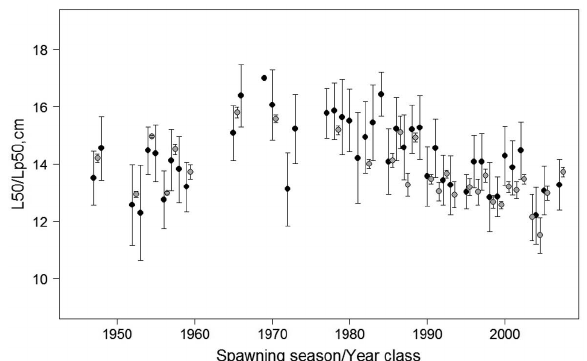
Fig . 4. – Variation in L (black symbols) and Lp (grey symbols) 50 50 of first-time spawners during the period 1948-2007. Bars represent ±2 standard errors of estimates. Fig . 5. – Variation in Lp ing season for the 1986 cohort. Bars show ±2 standard errors of